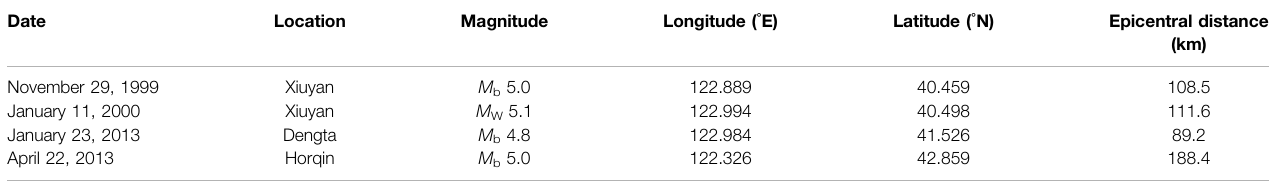
TABLE 1 | Earthquakes of M ≥ 4.8 within 300 km of the Panjin observation well, Liaoning province (1994 – 2020).